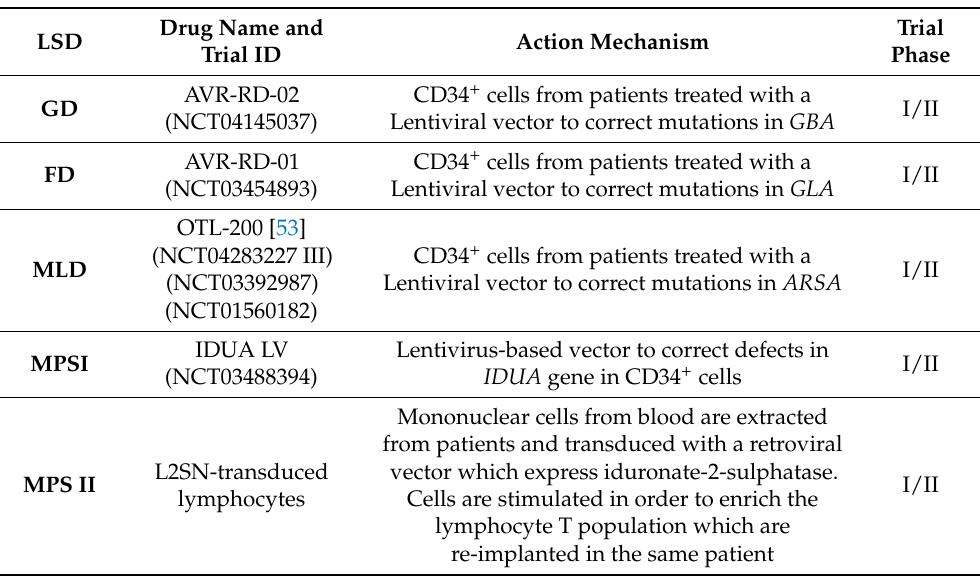
Table 2. Ex vivo gene therapy vectors under development for the treatment of